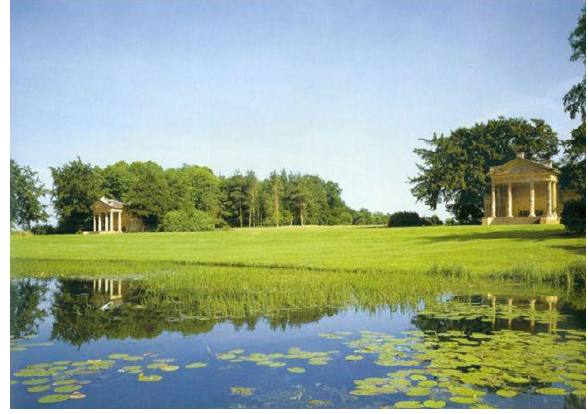
Figure 7. William Kent, Stowe gardens (Photo by Paola Gullino)